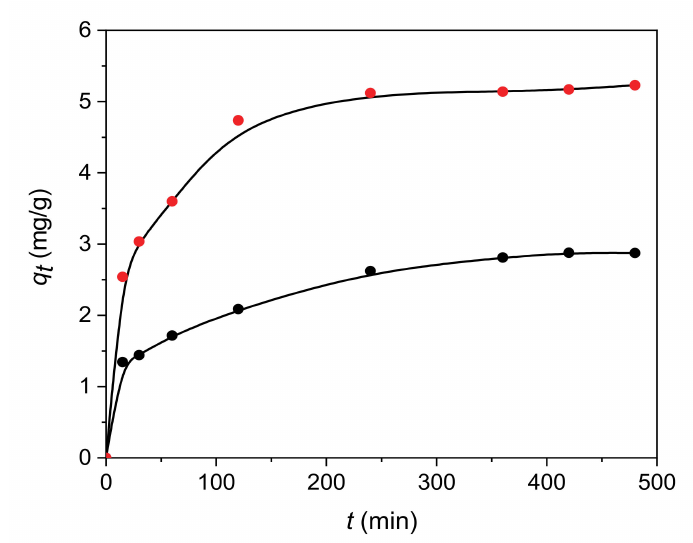
Figure 5. Kinetic adsorption curves of paracetamol on H (black circles) and 30 C / H (red circles)